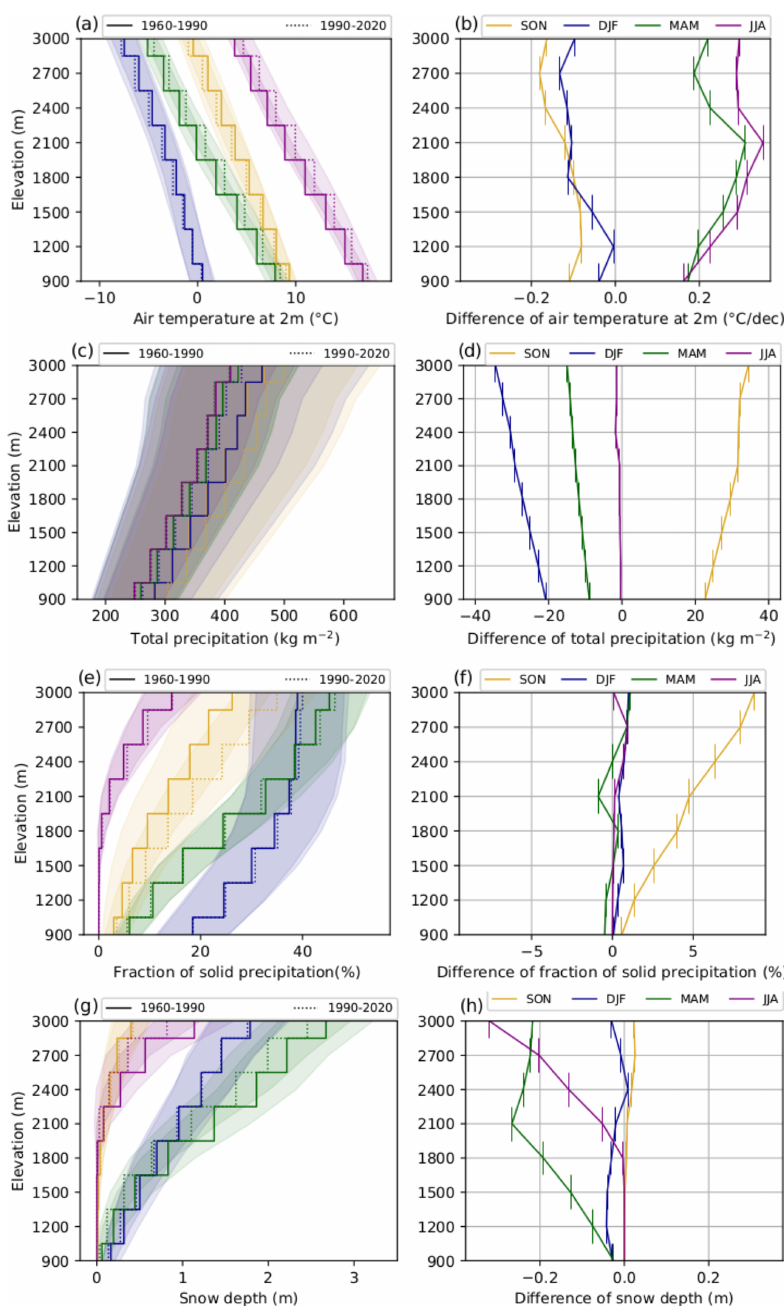
Figure 9. Difference of mean simulated 2m temperature (a, b) , total precipitation (c, d) , fraction of solid precipitation (e, f) and snow depth (g, h) for the different elevations and seasons between the periods 1960–1990 and 1990–2020 over the Alps. The envelopes represent the variability between the massifs. Vertical bars on the right column indicate the 300m elevation range that is covered by the corresponding